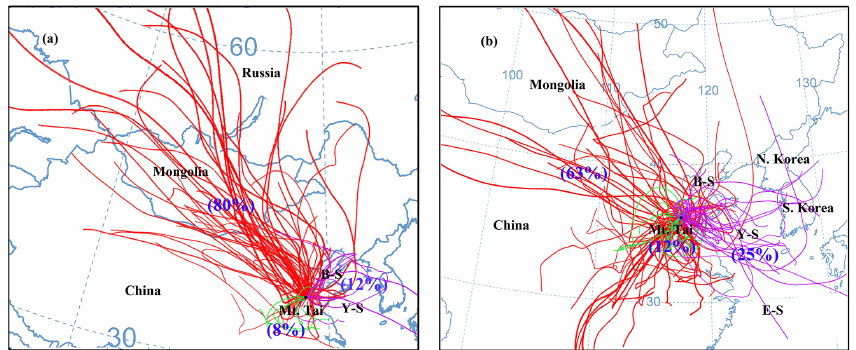
Figure 5. Air mass backward trajectories for 72h at 06:00LT at 1535ma.s.l. on all NPF days (a) and non-NPF days (b) , and the continental air mass, local air mass, and maritime air mass are represented in red, green, and magenta, respectively. B-S: Bohai Sea; Y-S: Yellow Sea; E-S: East China